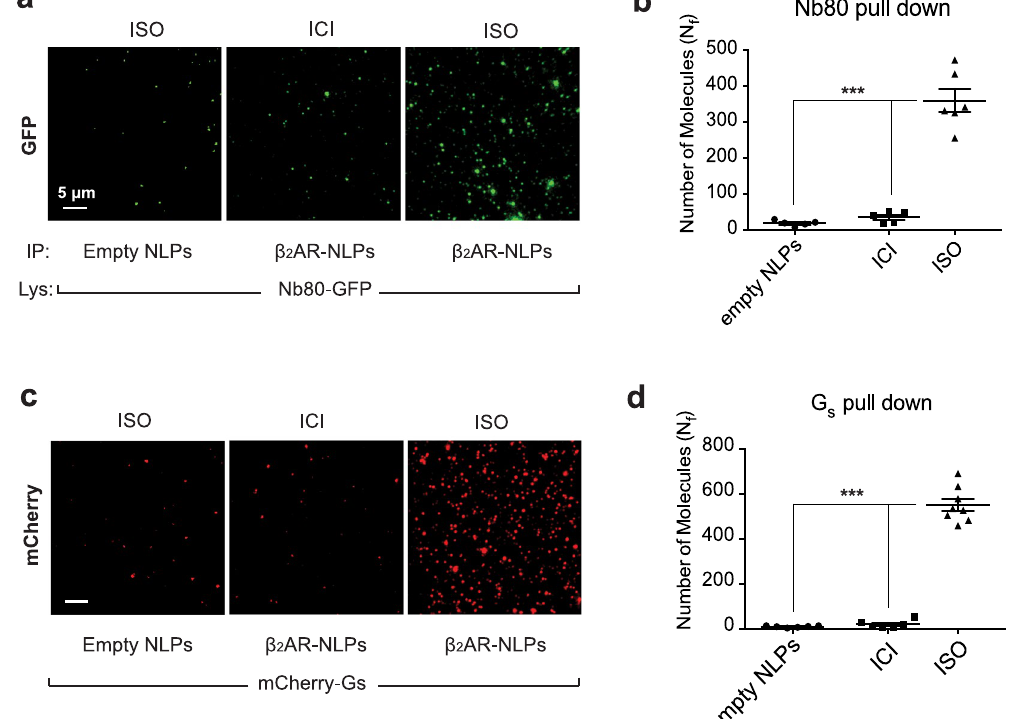
Figure 3. Functional characterization of β 2 AR-NLPs for binding to Nb80-GFP or cognate Gs-protein. ( a , c ) Purified β 2 AR-NLPs or empty NLPs were immobilized on a chip via anti-flag antibody (M2, Sigma). Nb80-GFP or Gs-mcherry-containing HEK cell lysates were flown over the immobilized β 2 AR in the presence of either the β μ M) or the β μ M). ( b , d ) Average number 2 AR agonist isoproterenol (ISO, 10 2 AR antagonist ICI118551 (ICI, 10 of fluorescent molecules per imaging area, N f . Results are shown as mean ± s.d. (n > 5; *** p <